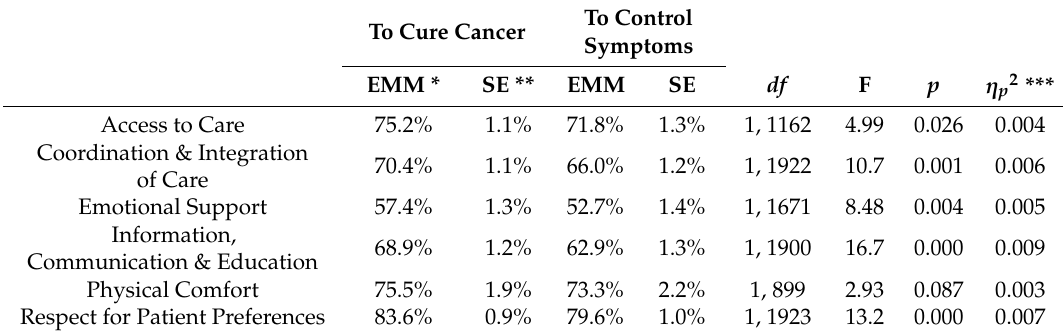
Table 2. Six dimensions of person-centred care and goals of treatment.